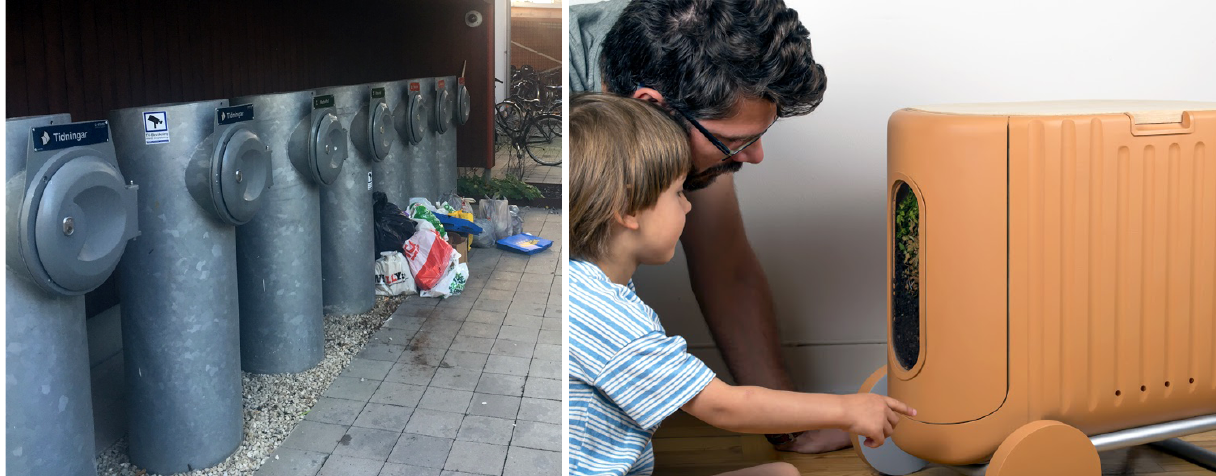
Figure 1a. A vacuum system for waste management in Kvillebäcken, Gothenburg. Photo credits: Pernilla Hagbert. 1b. Super Local Heating. Photo credits: David